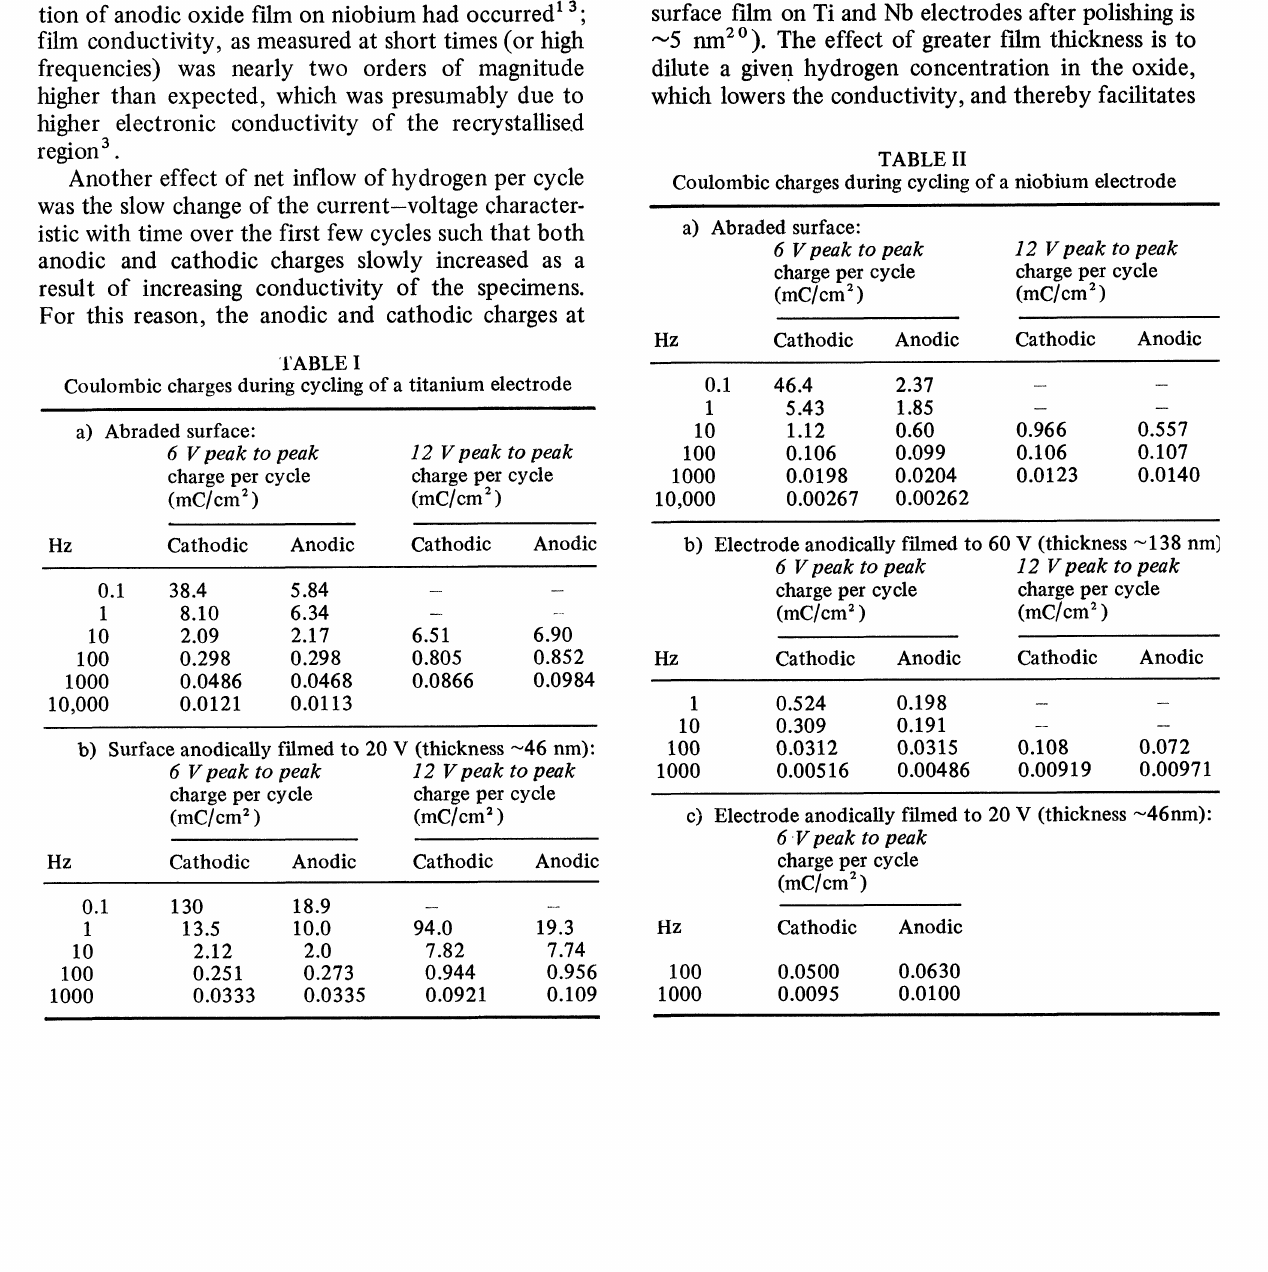
TABLE II Coulombic charges during cycling of a niobium electrode a) Abraded surface: 6 V peak to